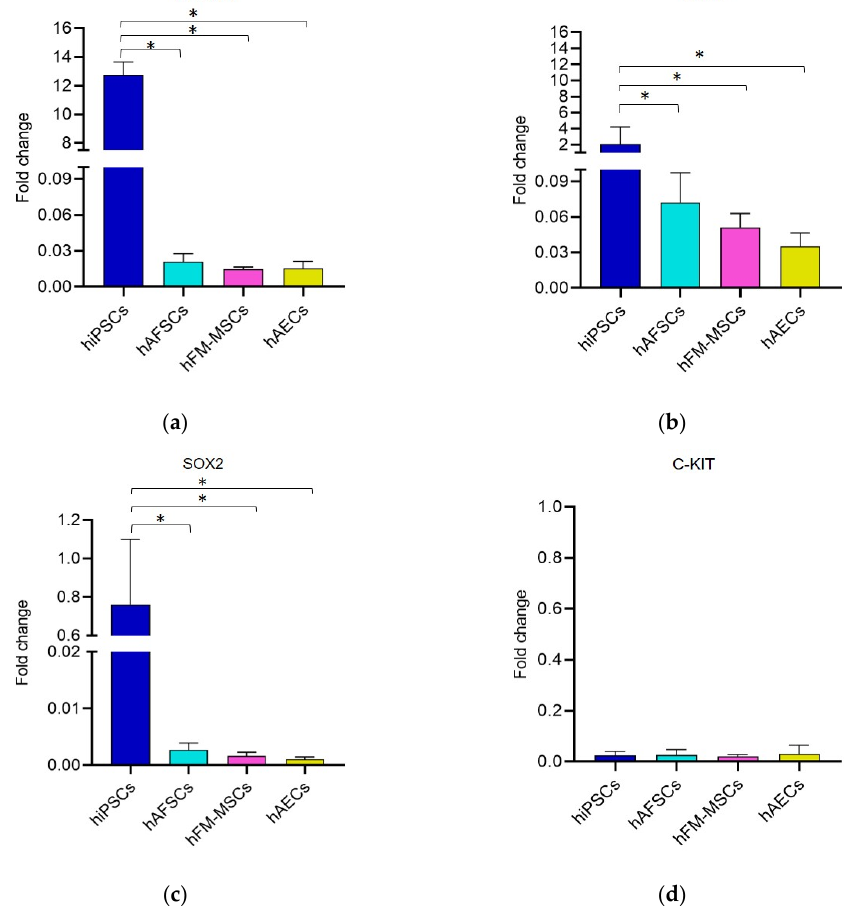
Figure 2. The gene expression analysis for “stemness genes” in hiPSCs and perinatal SCs. The gene expression of ( a ) NANOG , ( b ) OCT4 , ( c ) SOX2 , and ( d ) C-KIT detected by real time PCR in SCs from different sources. The fold changes were determined from the −ΔΔ Ct values calculated using 18S as a reference gene and normalized to hESCs, as the control condition. The graphs show the mean ± SD of 5 independent experiments, * p < 0.05.